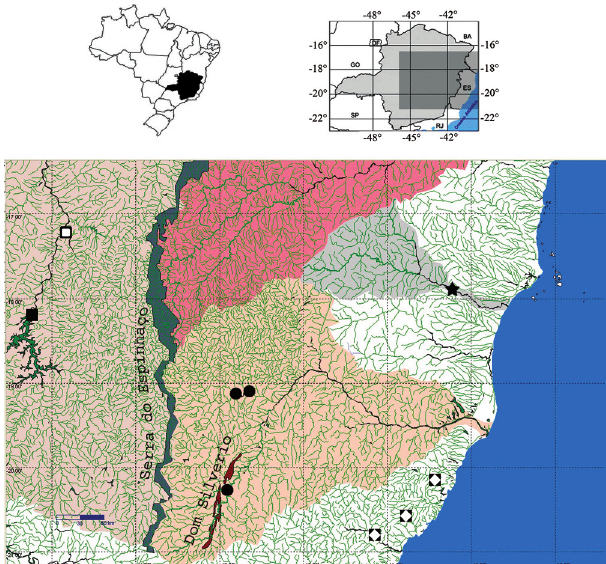
Fig. 6. Map of eastern Brazilian drainages at northeastern Minas Gerais State illustrating regional uplifts: the Serra do Espinhaço (colored in dark gray) and Dom Silvério Group (colored in brown). Contour of river basins in the area as stated: rio São Francisco (in pink), rio Jequitinhonha (in rose), rio Mucuri (in light gray), rio Doce (in salmon). Collecting localities of Glanidium botocudo illustrated as black circles. Star indicates type locality. Regional centromochlin species at rio São Francisco basin are illustrated by squares (white - Glanidium albescens ; black - Centromochlus bockmanni ). Congener at southern coastal rivers of Espírito Santo, Glanidium melanopterum , is illustrated by white lozenges. Symbols may represent more than one locality. Limits of Serra do Espinhaço are based on Valadão (2009) and Dom Silvério Group based on Peres et al.